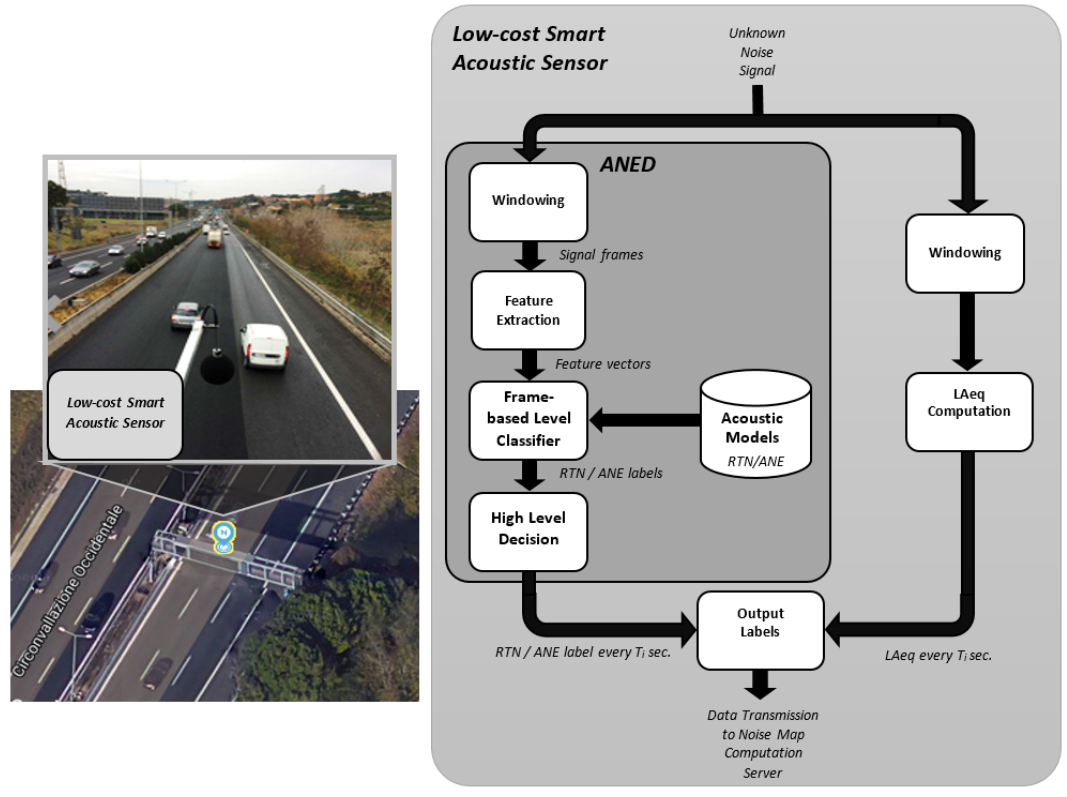
Figure 1. Example of the low-cost smart acoustic sensor positioning in a suburban environment (pictures loaned courtesy of ANAS S.p.A.) and the ANED functional block